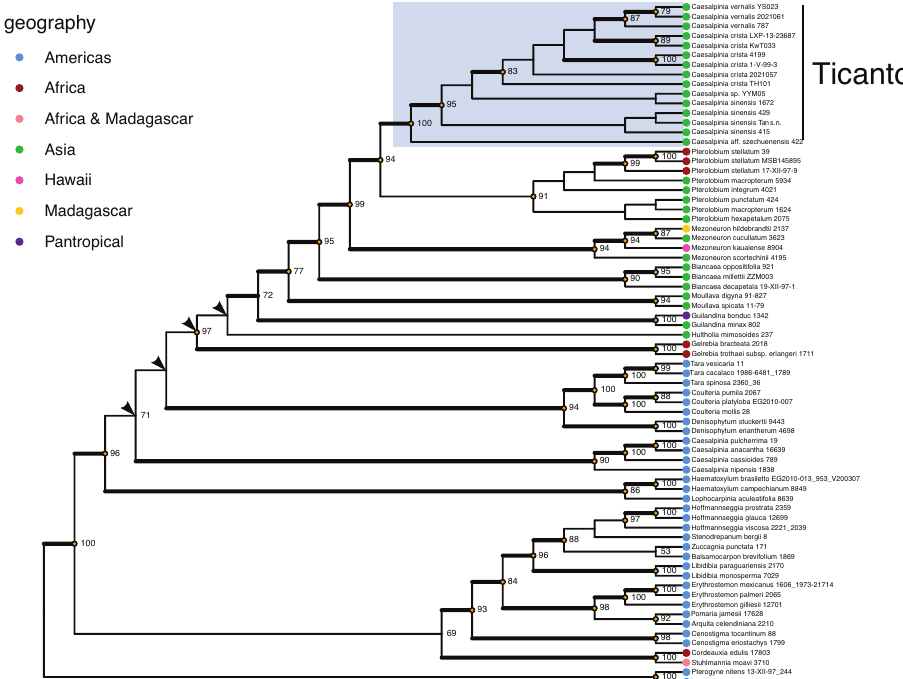
Figure 1. Caesalpinia group ML phylogeny from the combined dataset. Bootstrap values above 50 are shown, values > 75 are indicated with an orange dot at the node. Branches in bold indicate Posterior Probability greater than 0.95 in equivalent BI analysis. Arrows indicate nodes not recovered in BI analysis. The collector number of the corresponding voucher for each terminal is included with the species name. Where a terminal results from analysis of multiple vouchers, the collector numbers are separated by an underscore (see Suppl. material